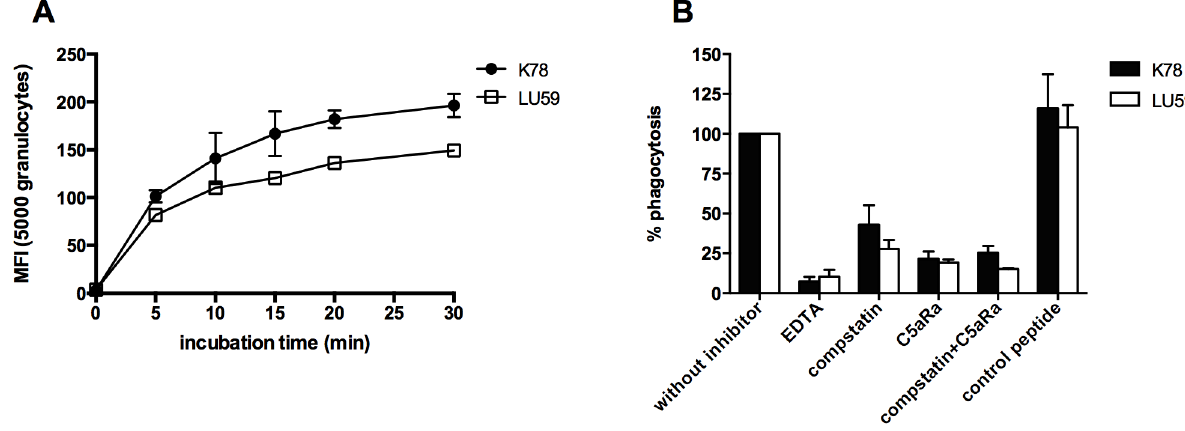
Figure 2. Importance of complement activation for efficient phagocytosis. FITC-labeled B. afzelii K78 and B.garinii LU59 were incubated in hirudin blood to study phagocytosis by measuring the mean fluorescence intensity (MFI) for granulocytes. A) Phagocytosis of each bacterial strain was monitored for 30 min. Results are presented as mean 6 SEM of two observations. B) The importance of complement activation in phagocytosis was analyzed by incubating Borrelia spirochetes in hirudin blood (n=3) with the addition of complement inhibitors acting at different stages in the activation cascade. Compstatin selectively inhibits the proteolytic activation of C3 and a C5a receptor antagonist (C5aRa) that blocks the C5a- mediated up-regulation of granulocytes and monocytes. A scrambled peptide of C5aRa was used as a control. The mean fluorescence intensity (MFI) for each bacterial strain incubated in hirudin blood without complement inhibitors was set to 100%. EDTA: ethylene diaminetetraacetic acid. C5aRa: C5a receptor antagonist.